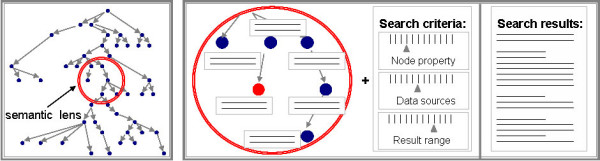
Visual, dynamic querying. A semantic lens is used to provide both a physical and semantic zoom. A specified node is then as input for a search and dynamic sliders are used to set search criteria. The provision of search ranges and data sources available aids users in determining information available to perform directed searches. Finally, transparent formatting of search syntax removes the need for users to learn complex query syntax.